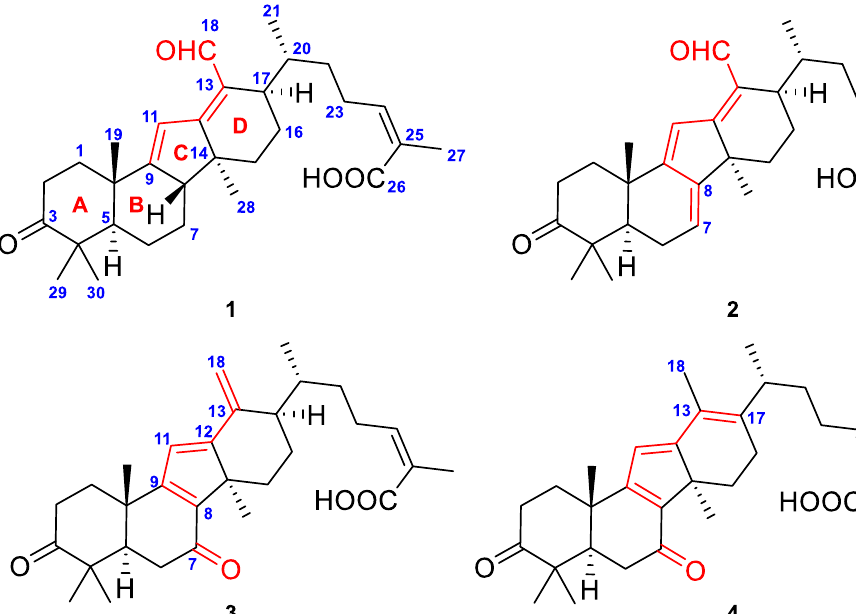
Fig. 1 Chemical structures of kadcoccitanes E–H ( 1 – 4 )